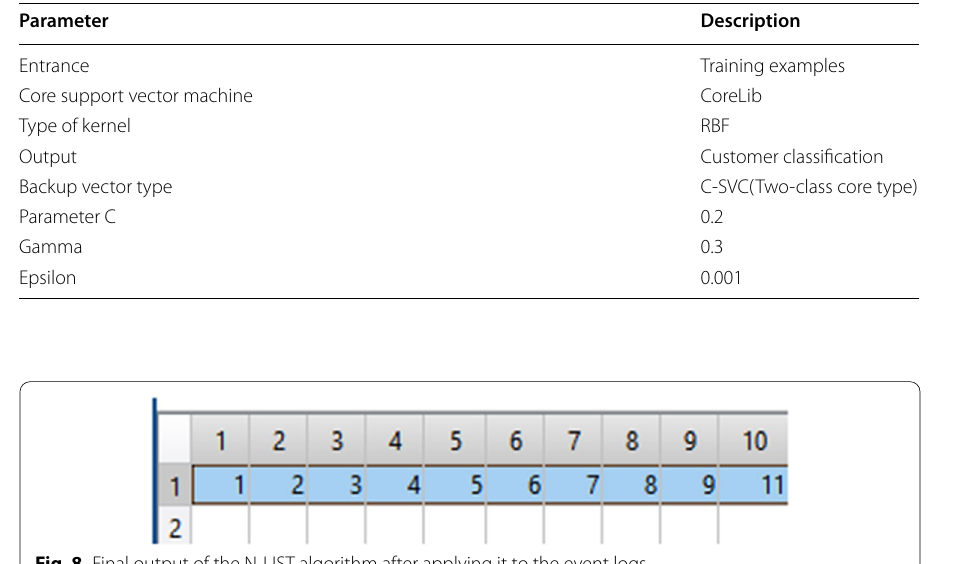
Table 9 Specifications of the SVM-Lib algorithm for portfolio analysis and customer